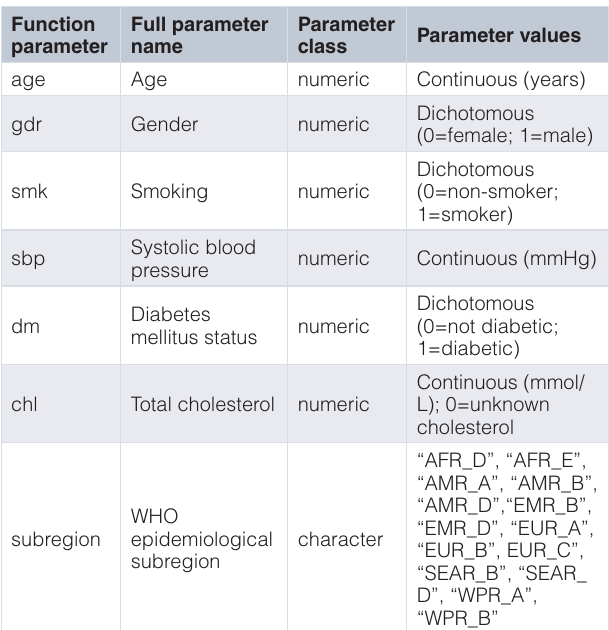
Table 1. Description of the WHO_ISH_Risk() function